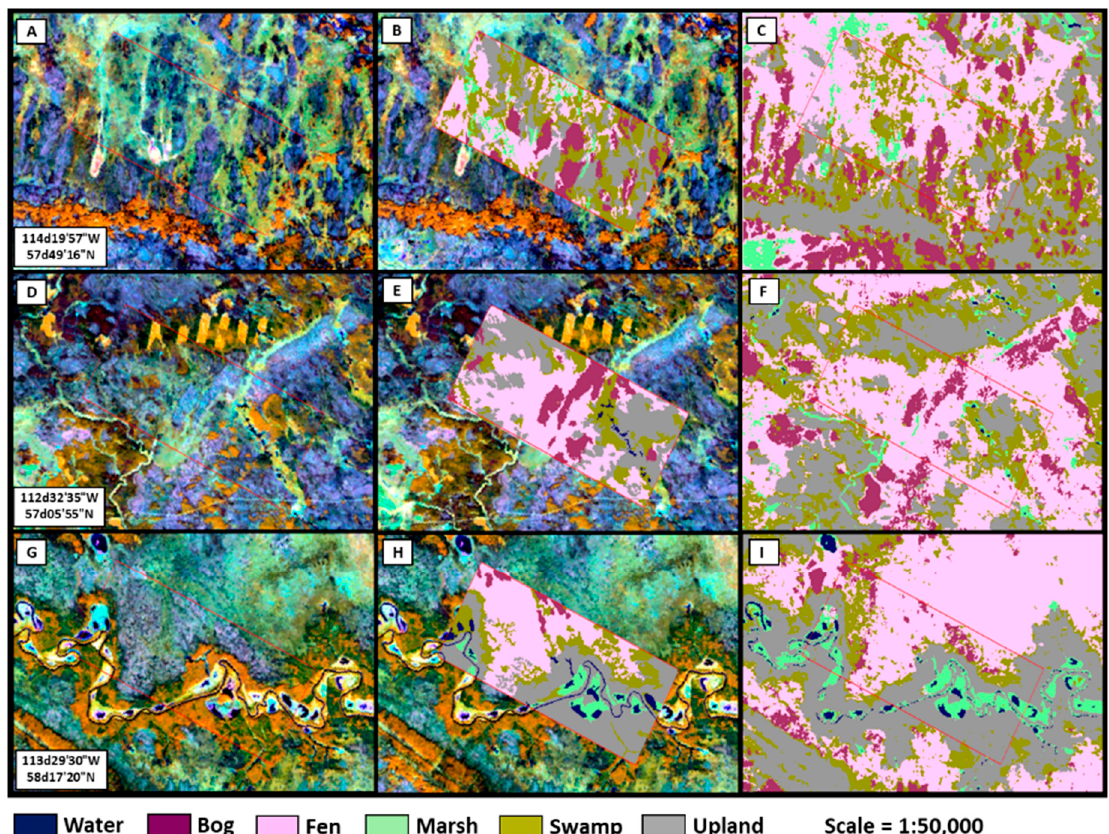
Figure 8. Example results of MSRE for three example ABMI photo-plots. Left panels are Landsat ( A , D , G ) displayed as red display = near infrared, green display = shortwave infrared, blue display = red. Center panels show the ABMI photo-plot ( B , E , H ), right panels show the MSRE classification ( C , D , I ).